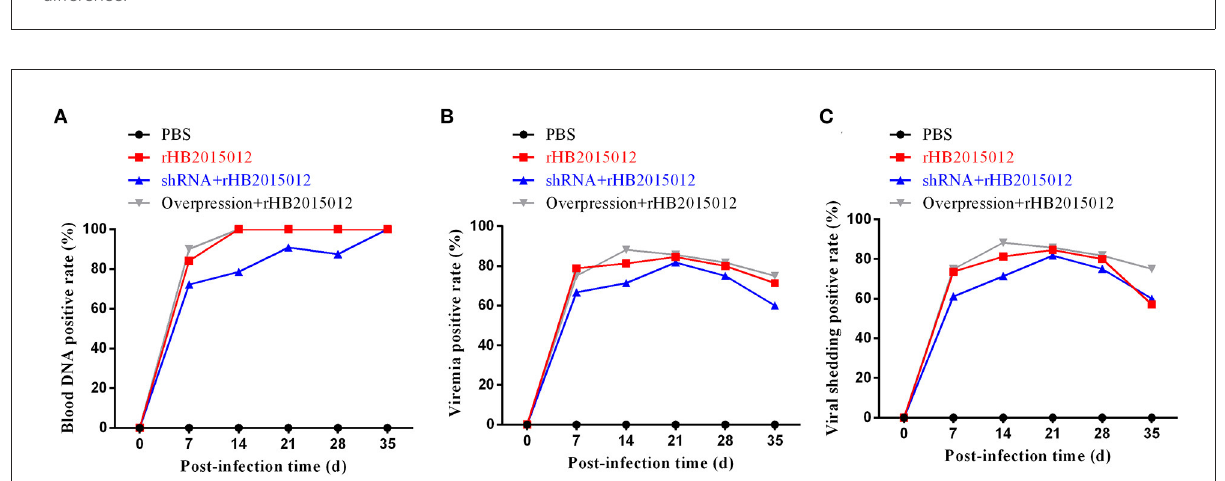
FIGURE6 ALV-A infection status, viremia and viral shedding. (A) Identifying ALV-A infection by blood DNA PCR. (B) Viremia after ALV-A infection was detected by ELISA. (C) Detecting viral shedding after ALV-A infection by anal swab p27 group-specific antigen ELISA.